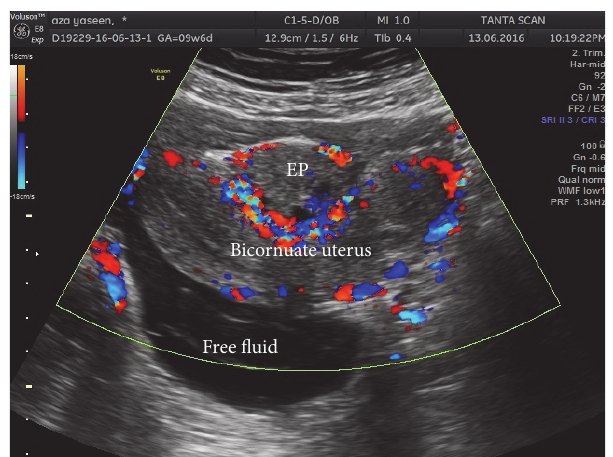
Figure 1: Doppler ultrasound showing bicornuate uterus and pelvic freefluid with the ectopicpregnancy site showing “Ring of Fire.”EP: ectopic pregnancy.